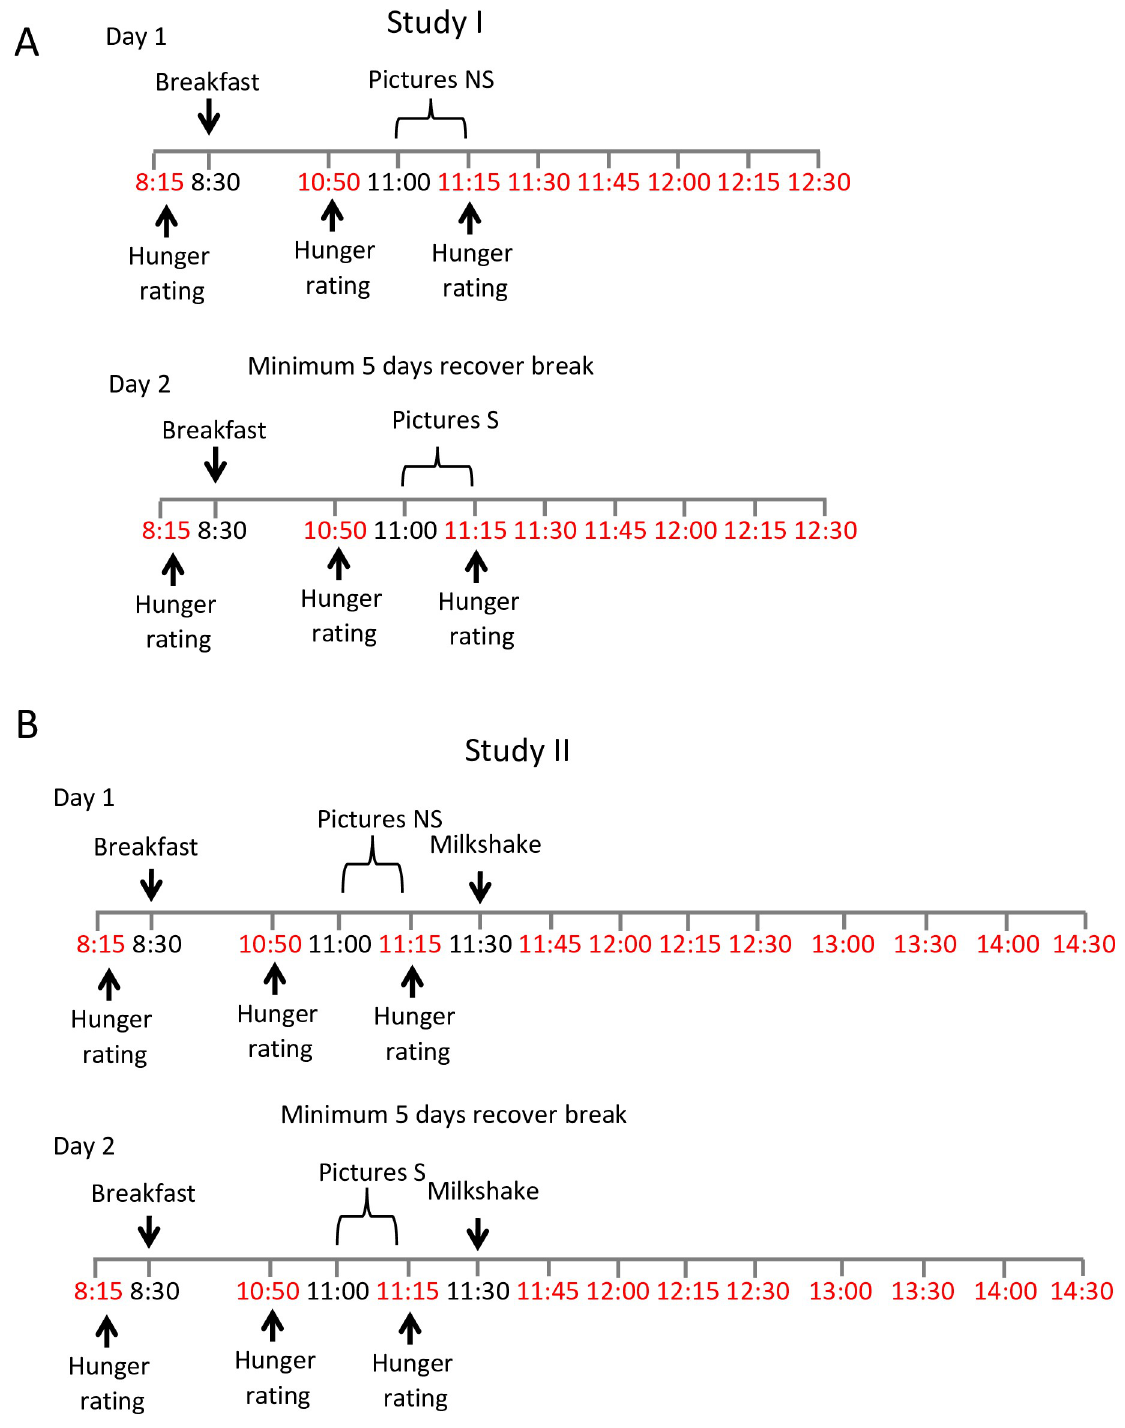
Fig 1. Schematic representation of the studies. During the study I (A) and study II (B) participants were given breakfast, asked to grade their hunger and to rate pictures of neutral objects or of food. For study II, following the picture session, the participants were given milkshake. The time points marked red indicate blood